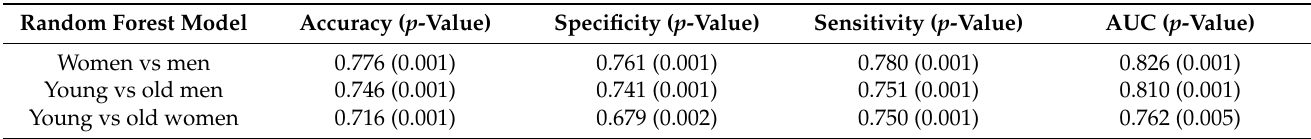
Table 6. Quality measures for the Random Forest classification models used to discriminate between the blood lipoprotein main fraction profiles of the study groups. Statistical significance was assessed using a permutation test.